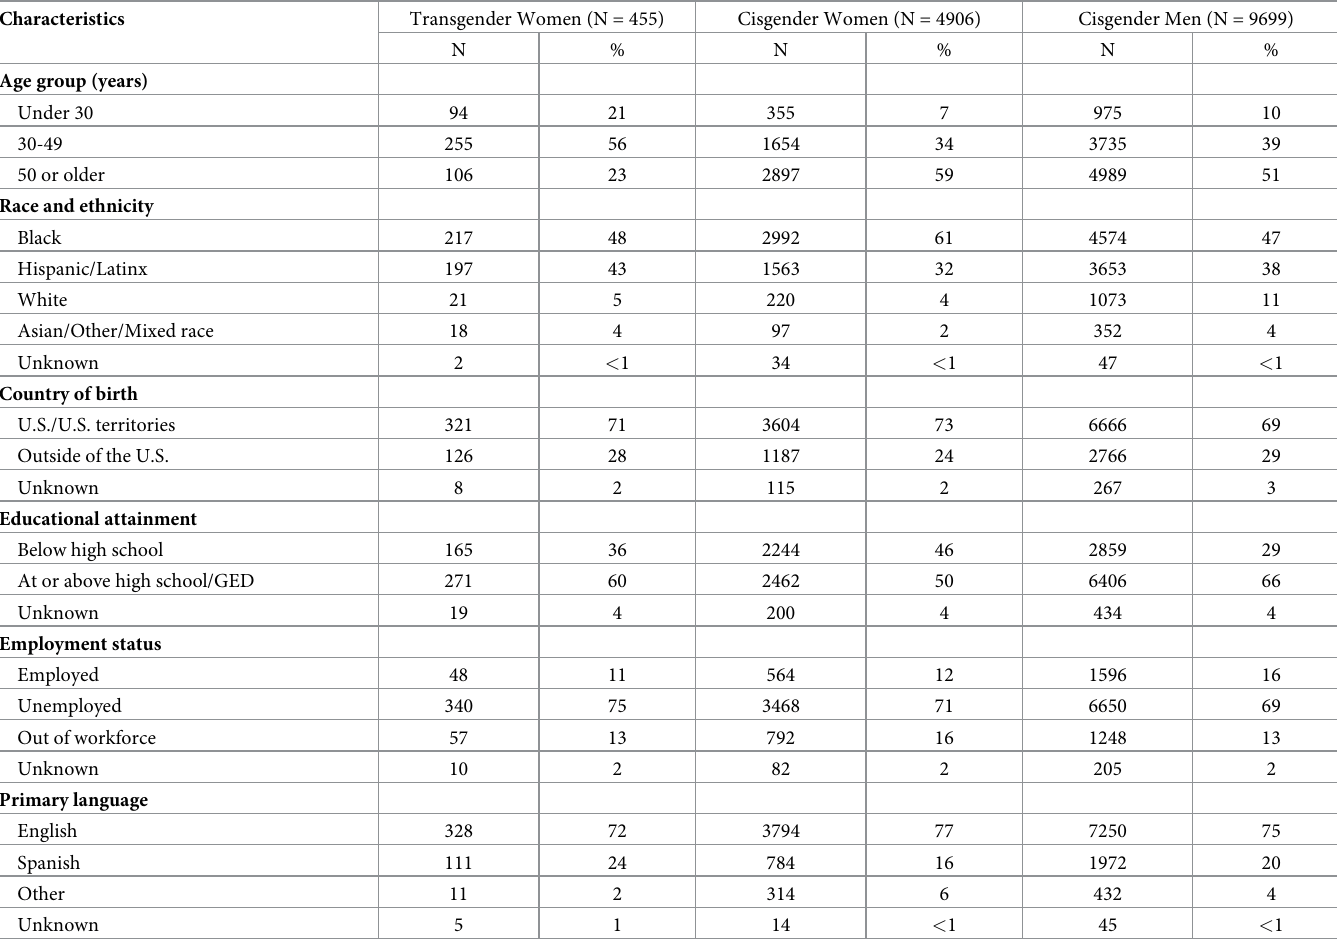
Table 1. Demographic characteristics of HIV-positive Ryan White Part A clients served and assessed between January 1, 2016 and December 31, 2017.